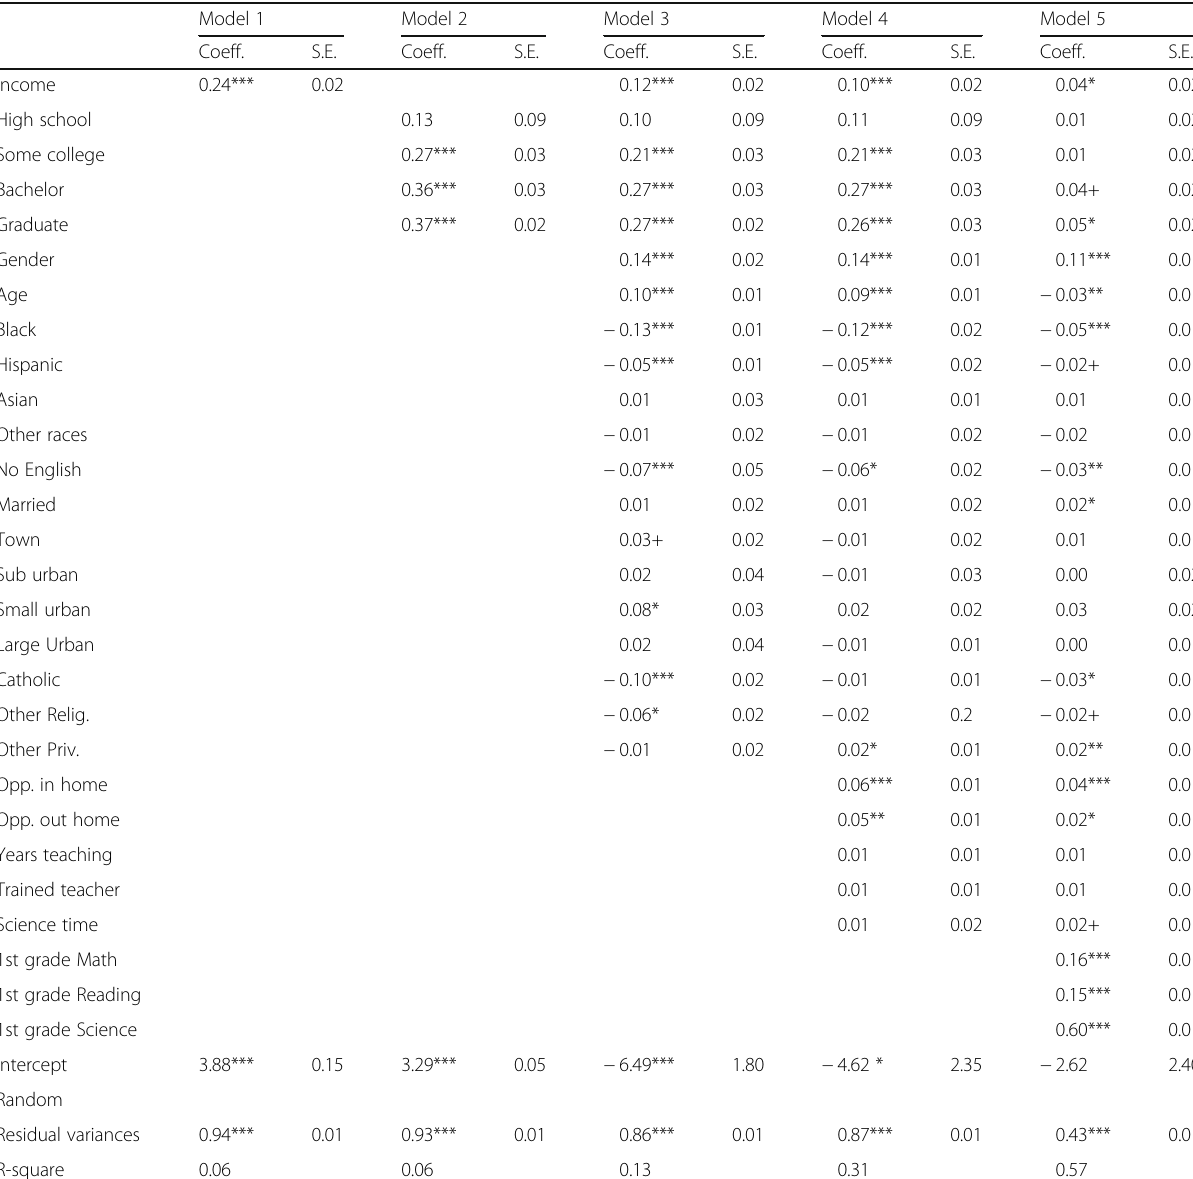
Table 2 Results for science at third